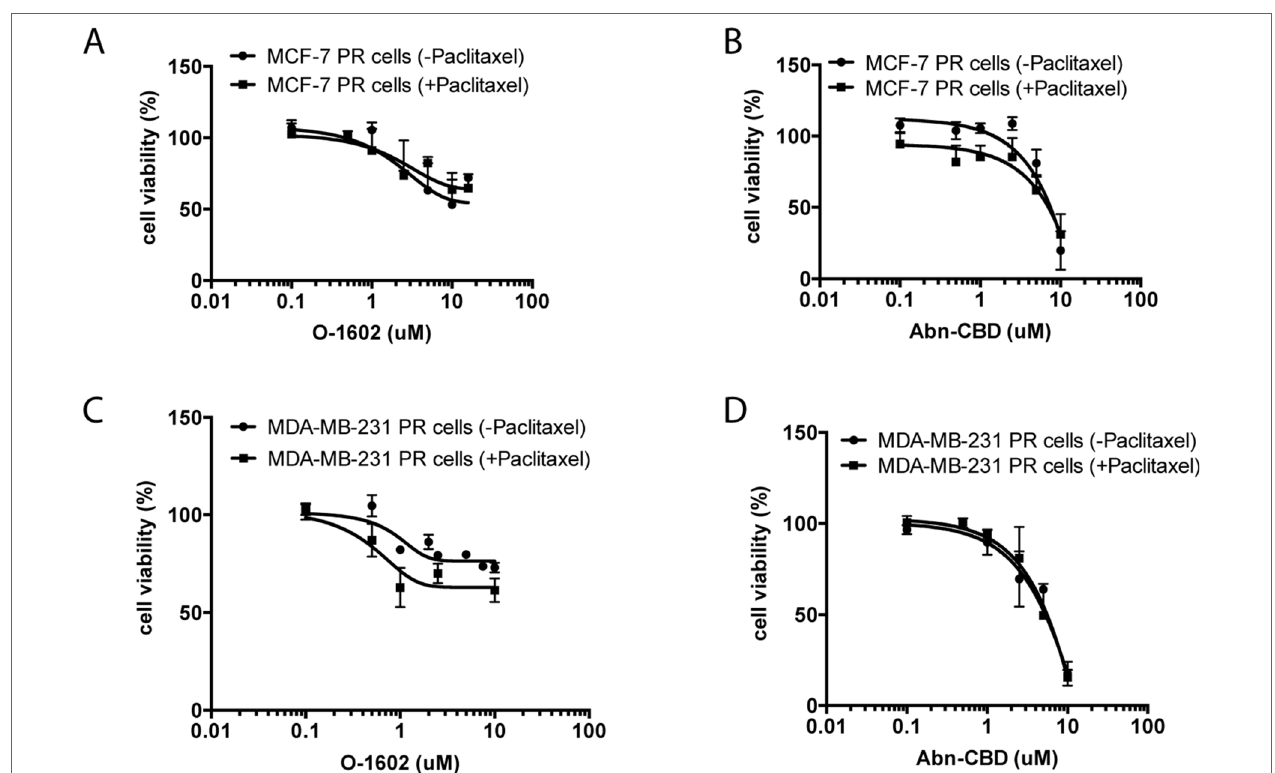
FIGURE 3 | Atypical cannabinoids effect on the viability of paclitaxel-resistant cells. (A) Cell viability measured in paclitaxel-resistant (PR) MCF-7 cells following 48-h treatment with various concentrations of O-1602 alone or in presence of paclitaxel. (B) Effect of Abn-CBD ± paclitaxel on MCF-7 PR cells. (C) Effect of O-1602 ± paclitaxel on MDA-MB-231 PR cells. (D) Effect of Abn-CBD ± paclitaxel on MDA-MB-231 PR